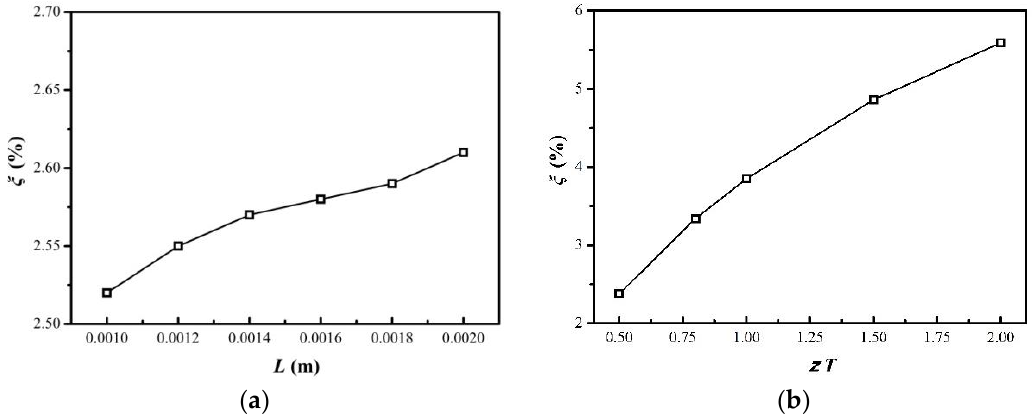
Figure 5. Influence of Z and L on the TE efficiency when the temperatures are maintained unchanged. ( a ) Z =1.49 × 10 −3 K −1 ( b ) L =1.5